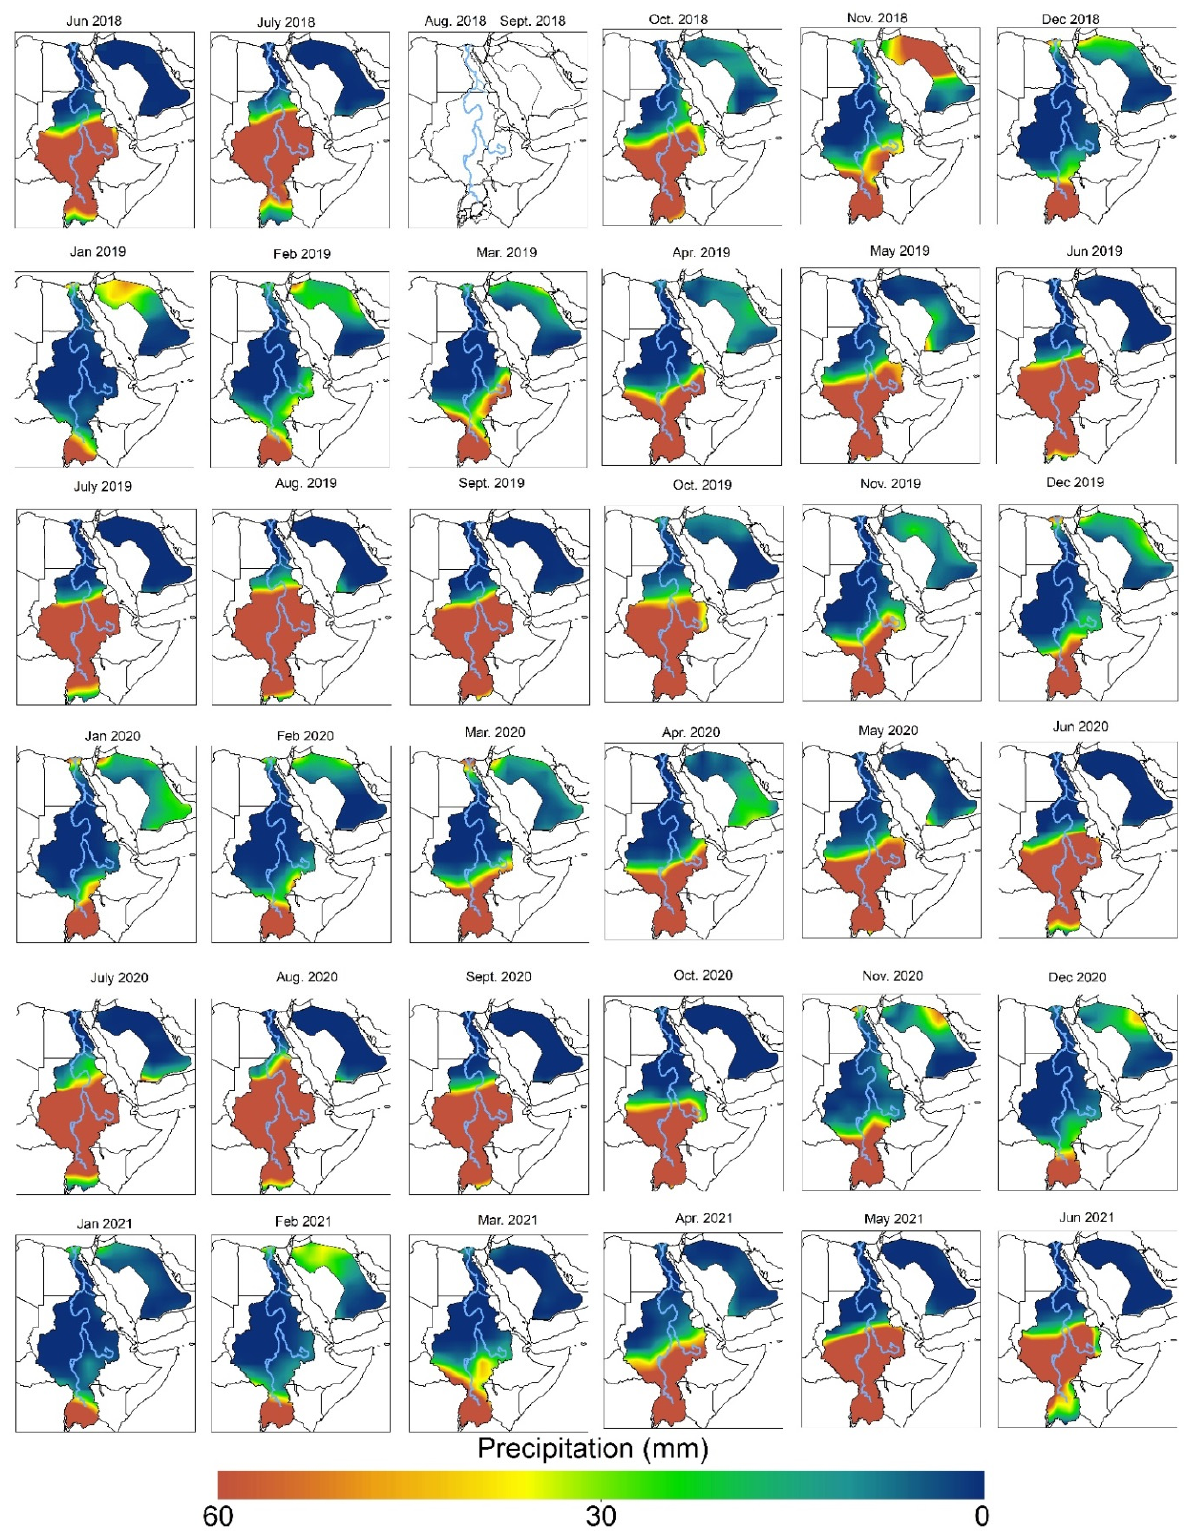
Figure 7. Spatial distribution map showing the average monthly precipitation in mm over the NRB and MAS for the whole study